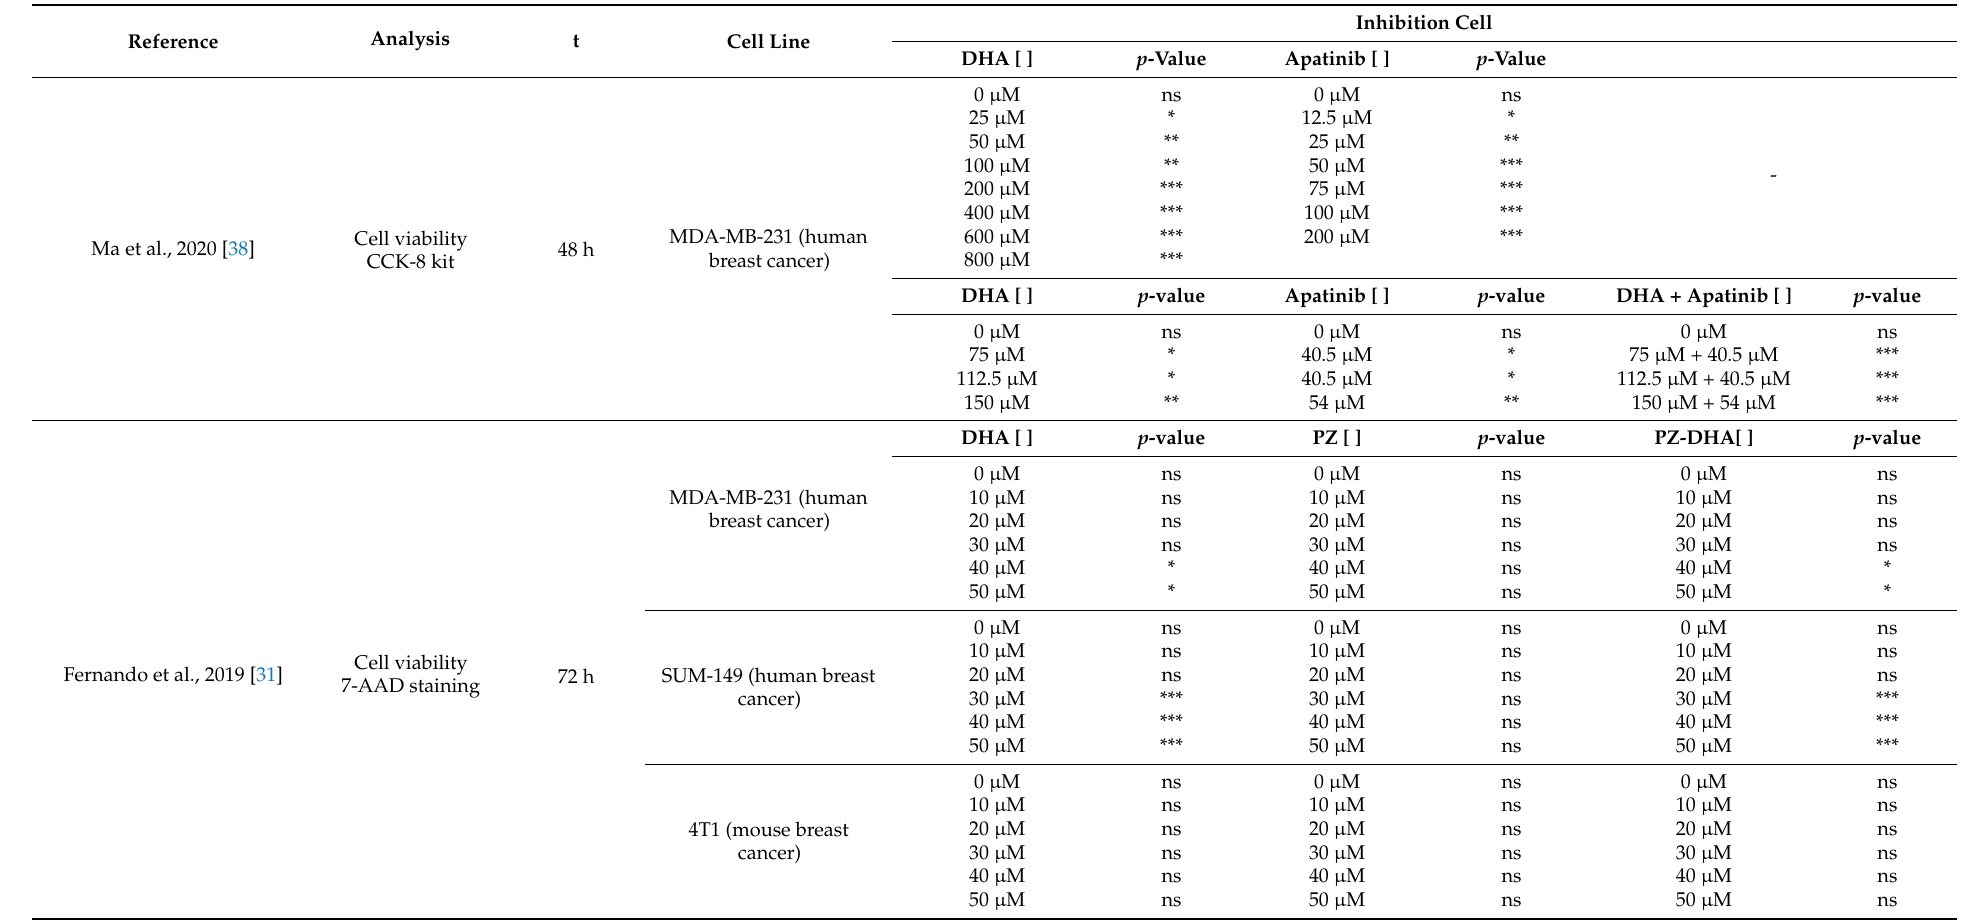
Table 2. Analysis results of the in vitro cytotoxicity tests on breast nontumor and cancer cell